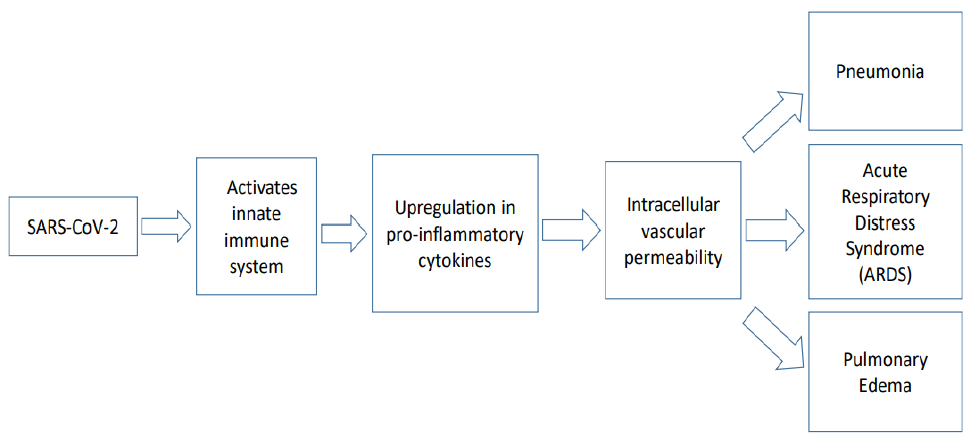
Figure 1. Molecular pathobiology of COVID-19.